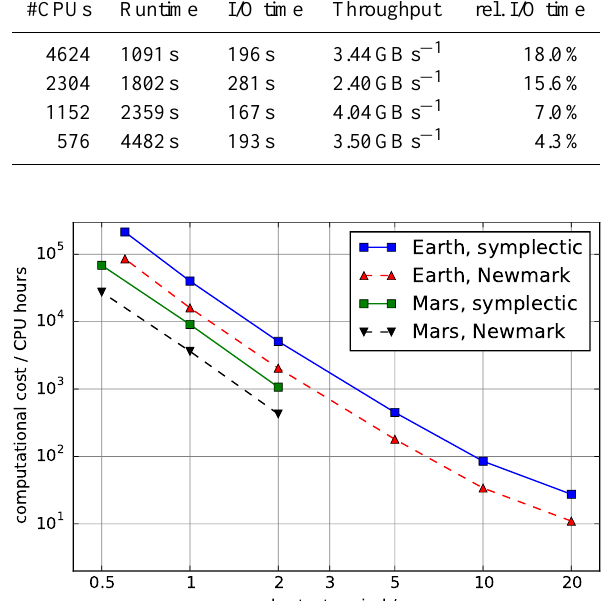
Figure 15. Computational cost in CPU hours (measured on Monte Rosa: a Cray XE6 for Earth and Piz Daint, a Cray XC30 for Mars) to generate full Instaseis databases with 1h long seismograms for two time schemes: 2nd order Newmark and 4th order